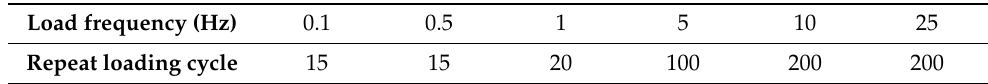
Table 5. Repeat loading cycles at different load frequencies.